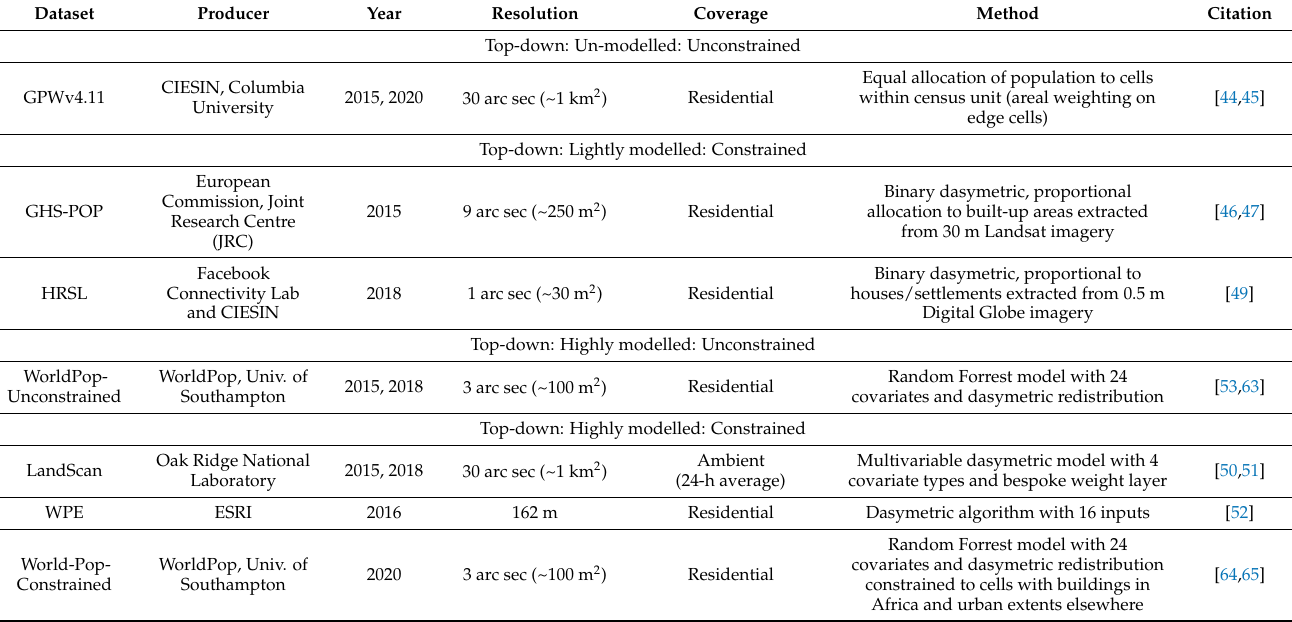
Table 1. Summary of gridded population datasets evaluated including their producer, year of estimate, native resolution, type of population covered by the estimate, and modelling